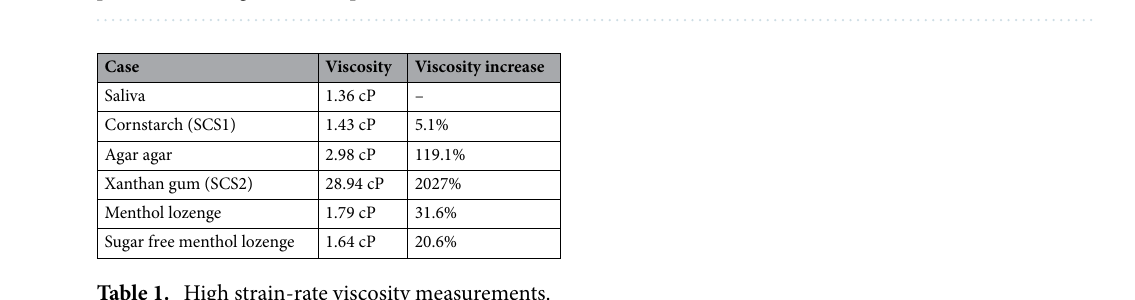
Figure 1. High-speed photography from human sneeze. Cases compare ( A ) baseline, ( B ) SCS1, ( C ) SCS2, and ( D ) masked. Each column represents a different point in time after the event along with the vertical intensity profile indicating overall droplet content.